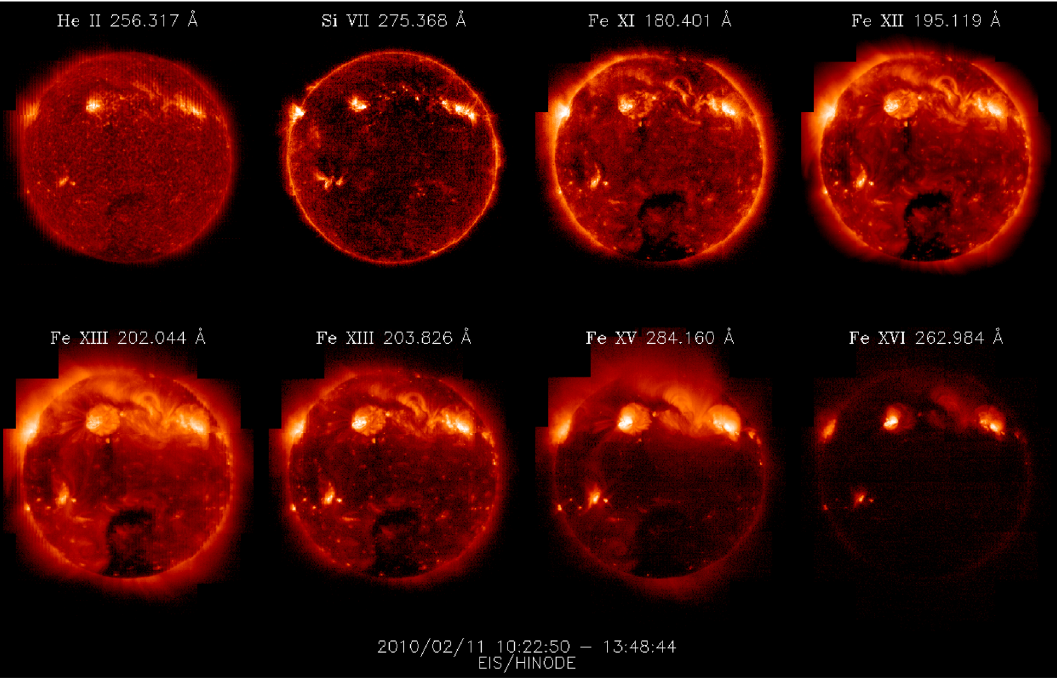
Fig. 2. Hinode /EIS produced a mosaic of slot images on 11 February 2010, to form a series of full disk images in spectral lines formed at temperatures ranging from <10 5 K (He II ) to ~3 (cid:3) 10 6 K (Fe XVI ), thereby illustrating the multithermal structuring of the EUV corona. (Photo credit: JAXA/NASA/ESA Hinode